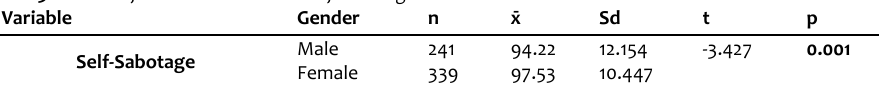
Table 3: Results of the T-Test between Self-Sabotage Scores and the Gender Variable Variable Gender n x̄ Sd t p Male 241 Self-Sabotage 10.447